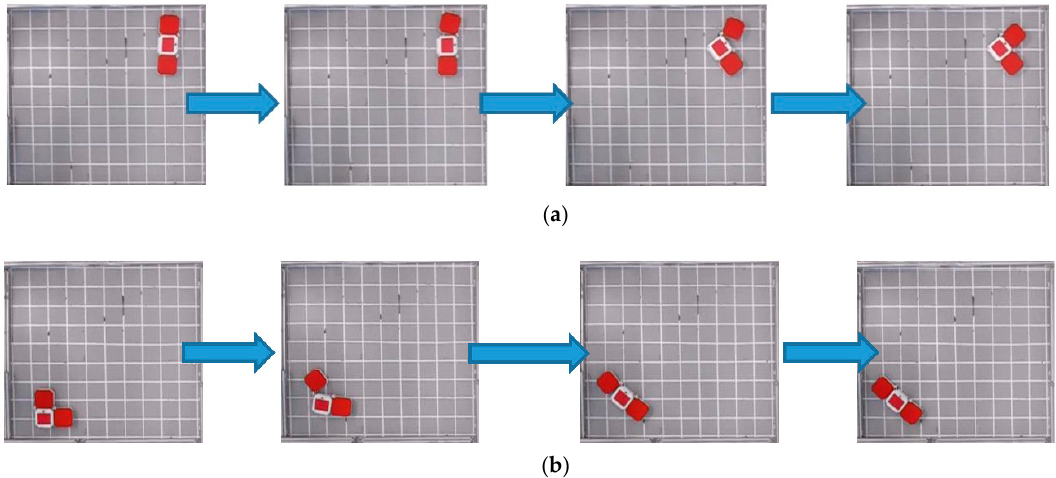
Figure 10. hTromo robot’s transformation from one configuration to another. ( a ) Transformation from I-tromino to L-tromino; ( b ) Transformation from L-tromino to I-tromino.